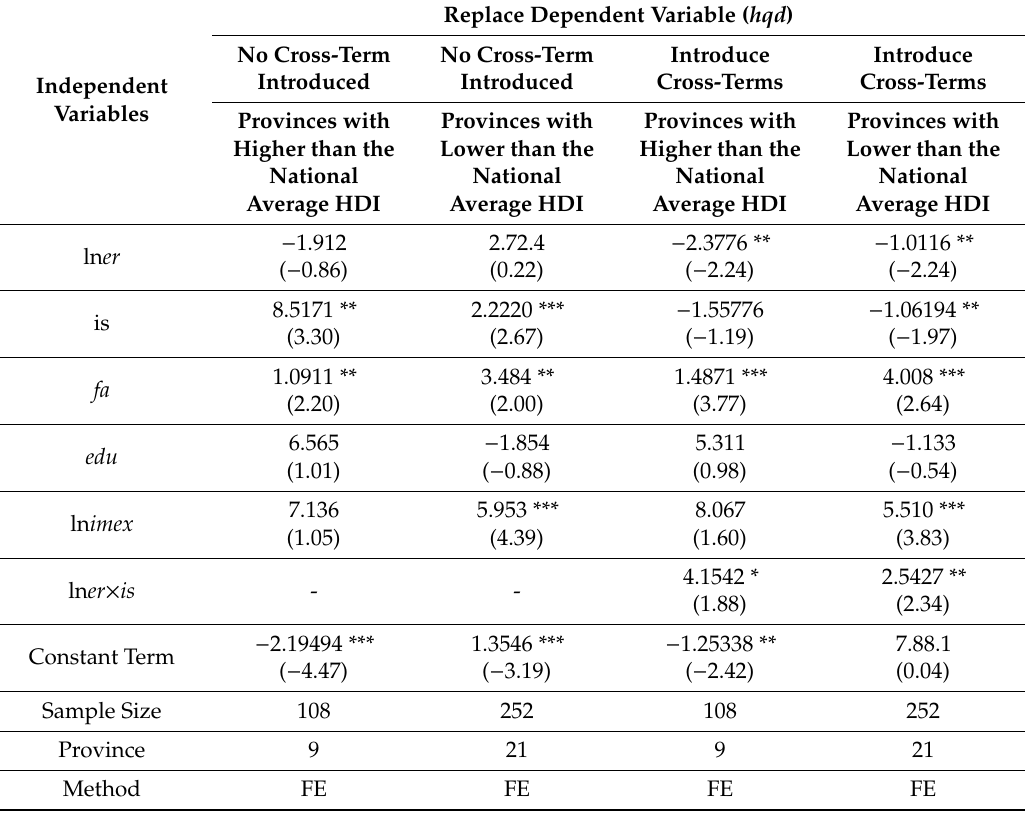
Table 6. Estimation results for the e ff ect of environmental regulations on the quality of economic development (robustness test with a substitute